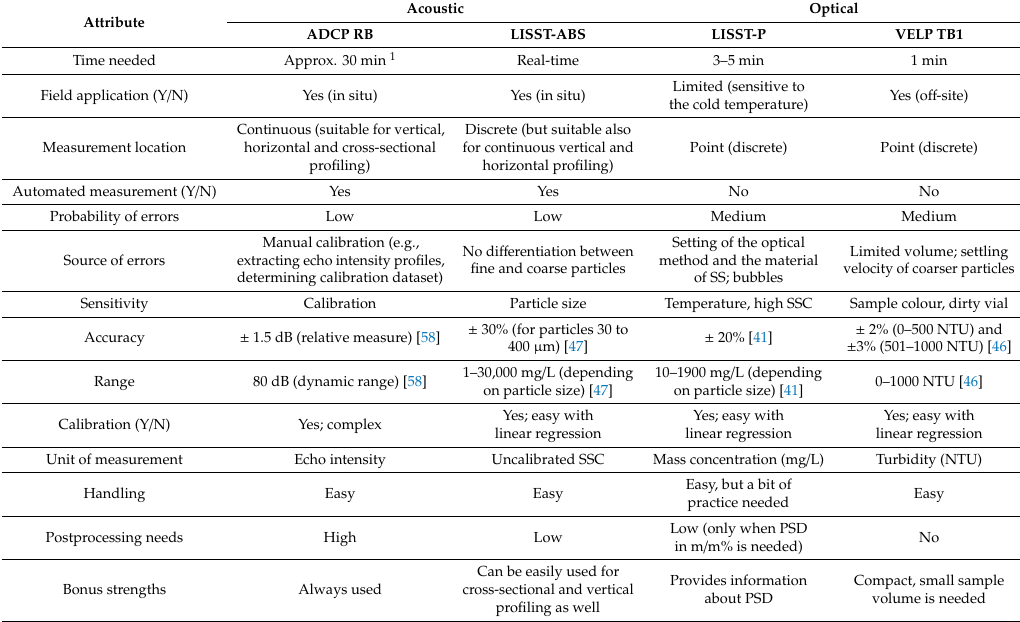
Table 3. Summary of selected attributes of the investigated indirect